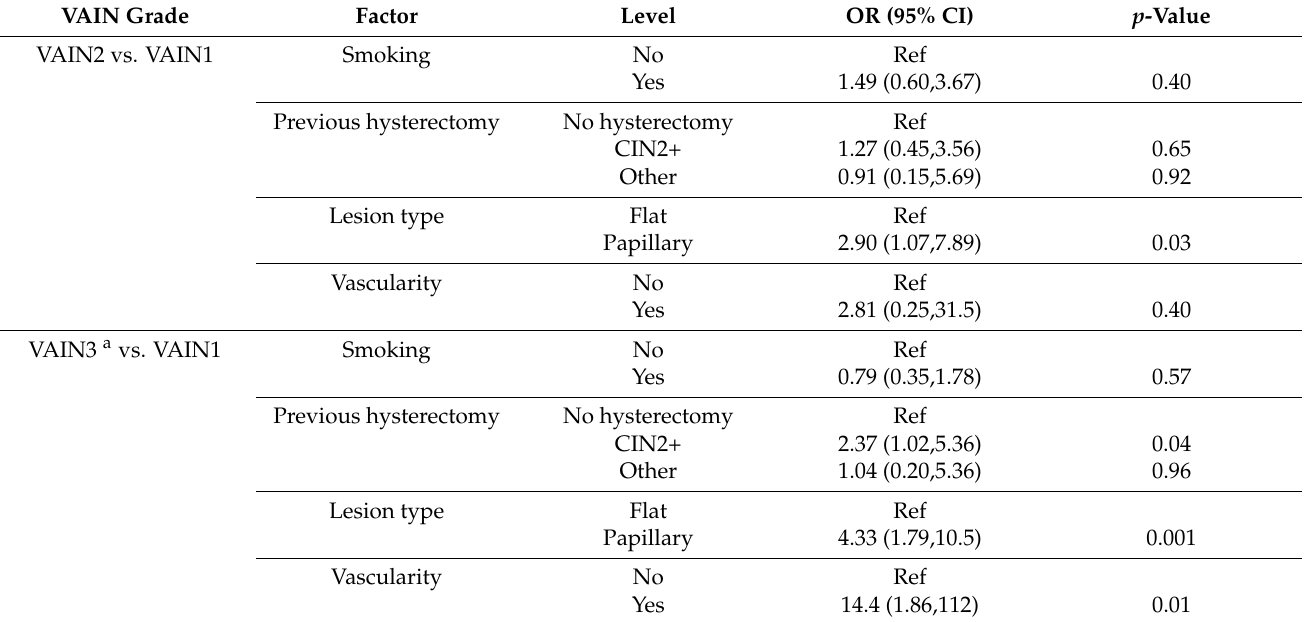
Table 5. Multivariate analysis of variance of risk factors for VAIN excluding colposcopic